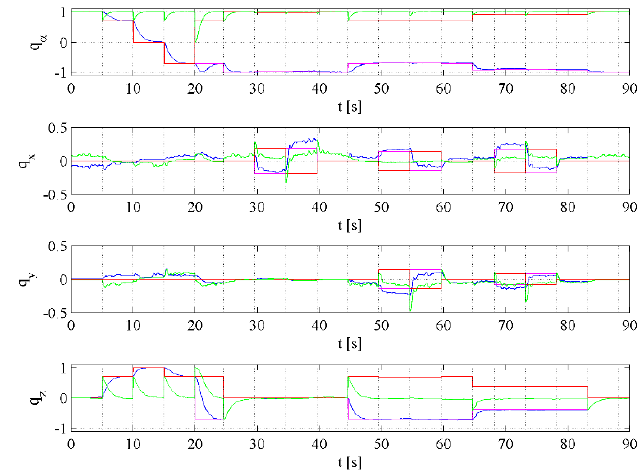
Figure 11. Performance of the sequence using the PD controller expressed by various quaternions, such as actual quaternion (blue line), quaternion error (green line) and desired quaternion (red and magenta line).